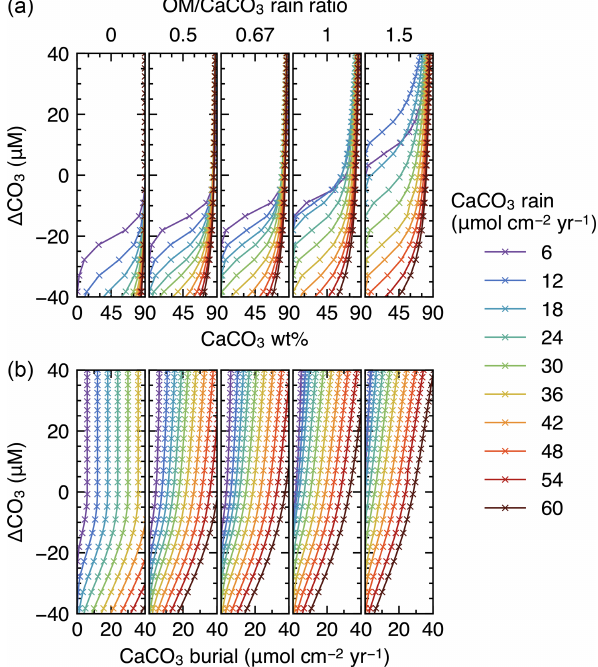
Figure 8. Estimated CaCO 3 weight fractions in mixed-layer (a) and burial fluxes (b) as functions of the CaCO 3 saturation degree and rain fluxes, with only oxic degradation of organic matter enabled. Saturation degree is measured by the difference of the carbonate ion concentration at the seawater–sediment interface from that at calcite saturation, (cid:49) CO 3 . The results shown are from the model with a shallower sediment depth (50cm) and single class of CaCO 3 particles.